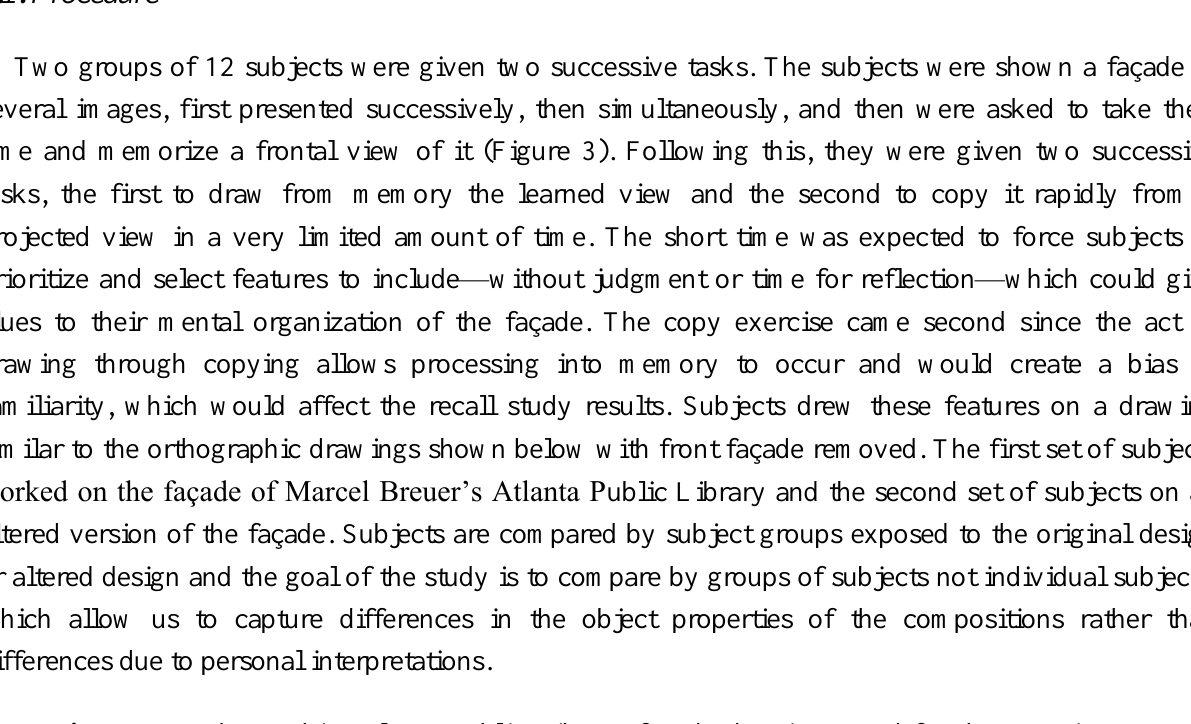
Figure 3. Orthographic Atlanta Public Library façade drawings used for the experiment. ( a ) Design by Marcel Breuer; ( b ) Design composition altered by research